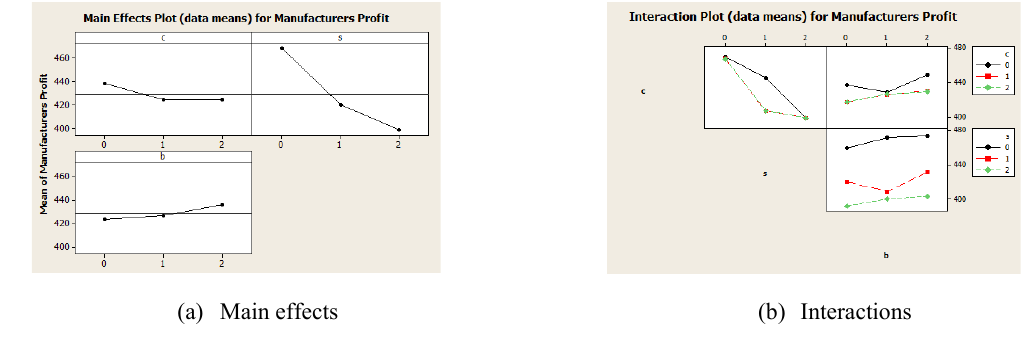
Fig. 8 . Main effects and interactions plot for the producer’s profit